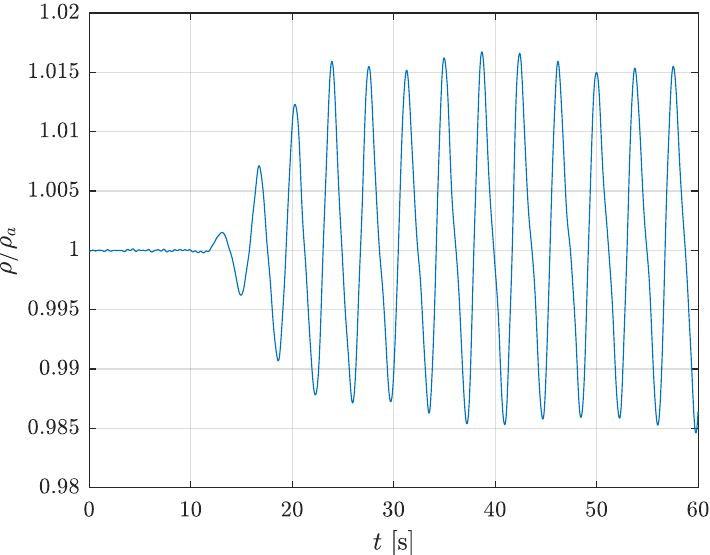
Figure 8. The variation in air density inside the chamber for Test 118, based on Equation